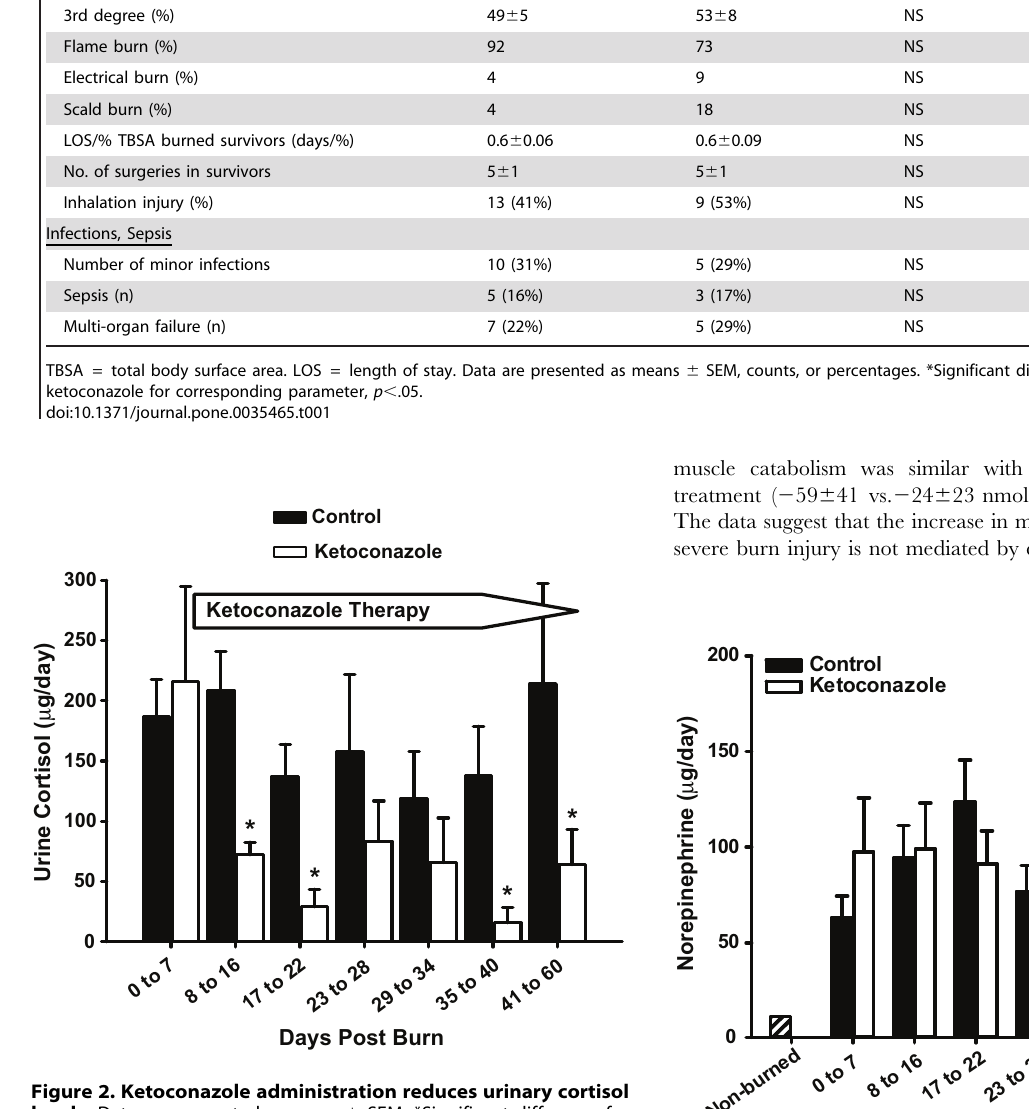
Figure 2. Ketoconazole administration reduces urinary cortisol levels. Data are presented as mean 6 SEM. *Significant difference for control vs. ketoconazole at corresponding time point, p , .05. There were no significant differences between control and ketoconazole- treated patients before ketoconazole treatment. Ketoconazole therapy was initiated by the first week post burn. Urinary cortisol approached normal values in ketoconazole-treated patients and was significantly decreased during therapy.